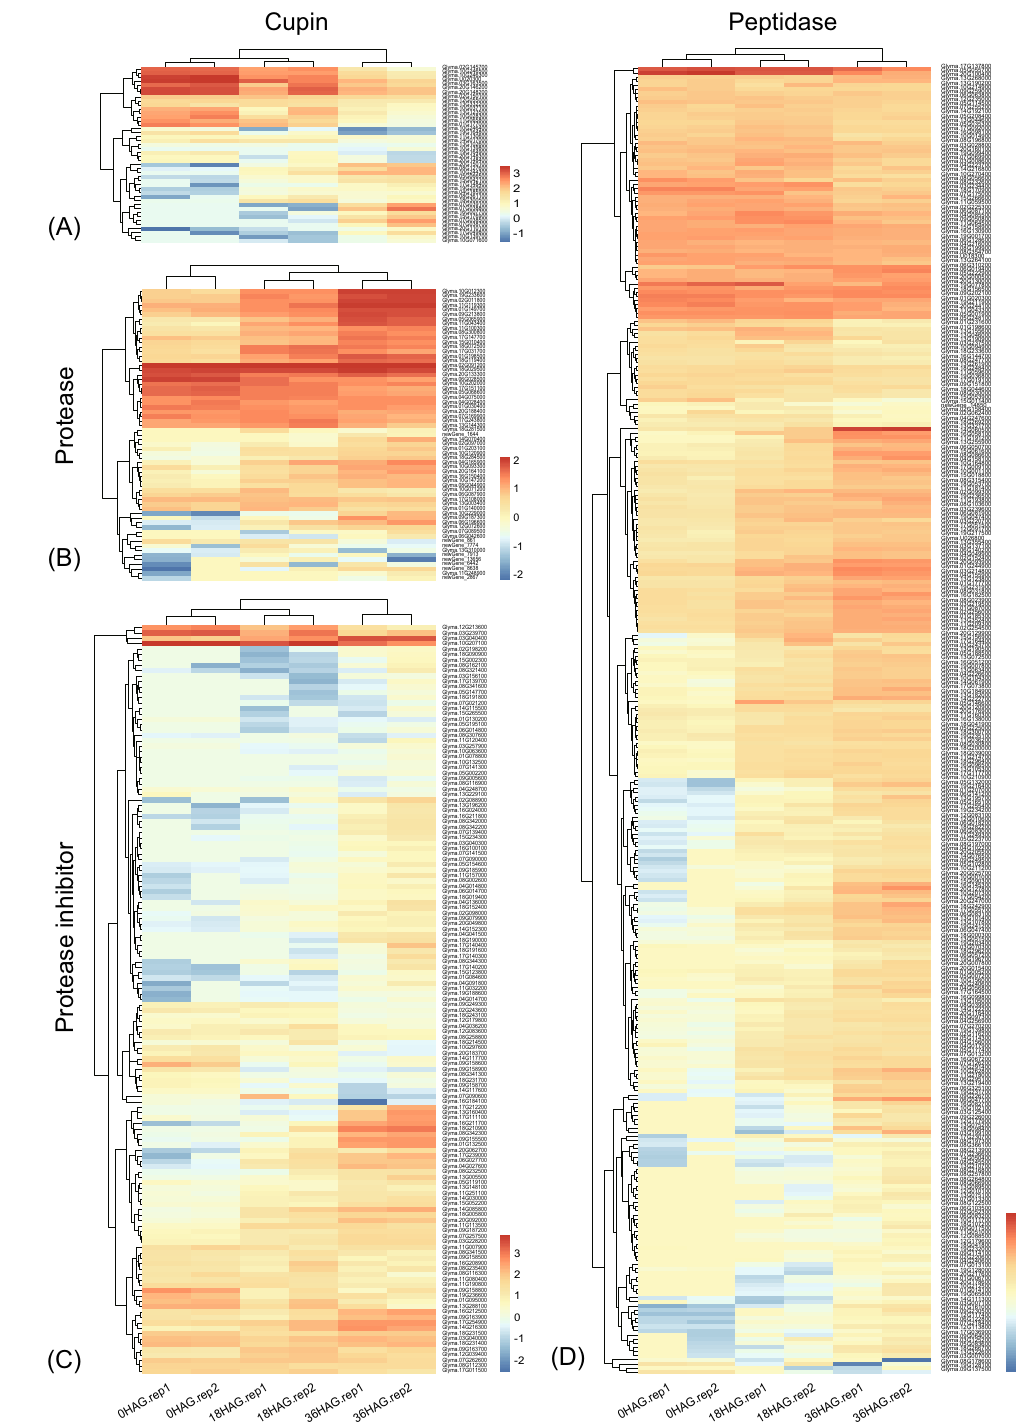
Figure 5. Heatmap of expression pattern of genes involved in protein metabolism. ( A–D ) expression pattern of genes coding for cupin, protease, protease inhibitor, and peptidase respectively. FPKM of each gene was transformed by log10 before